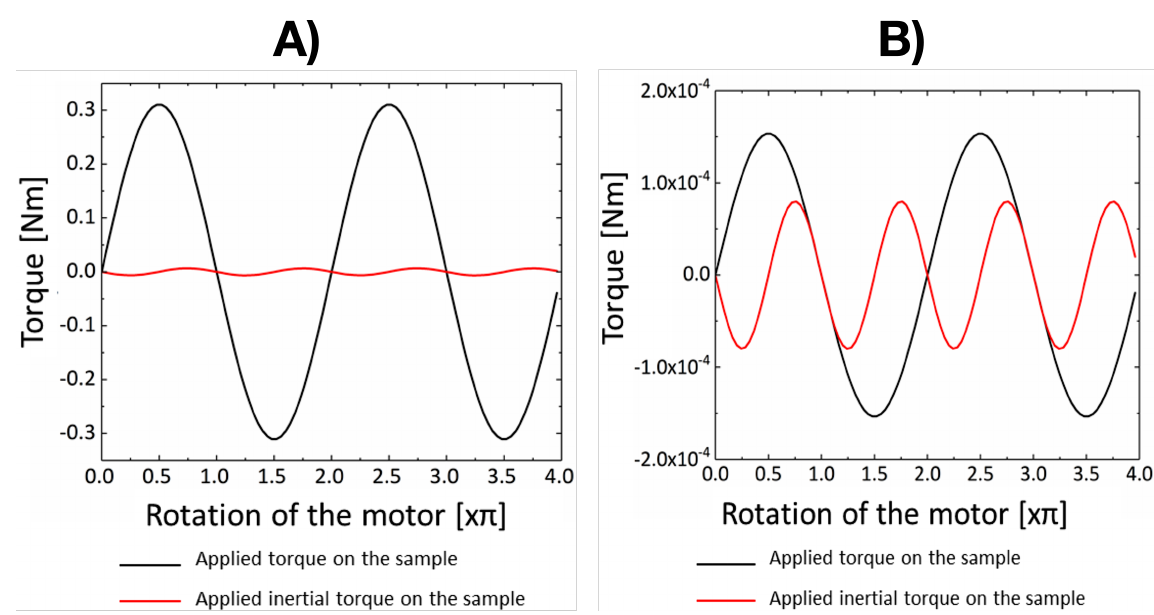
Figure 6. Dynamic and applied torque components for: (A) lever length 25 mm and eccentricity 0 . 9 mm; (B) lever length 125 mm and eccentricity 0 . 1